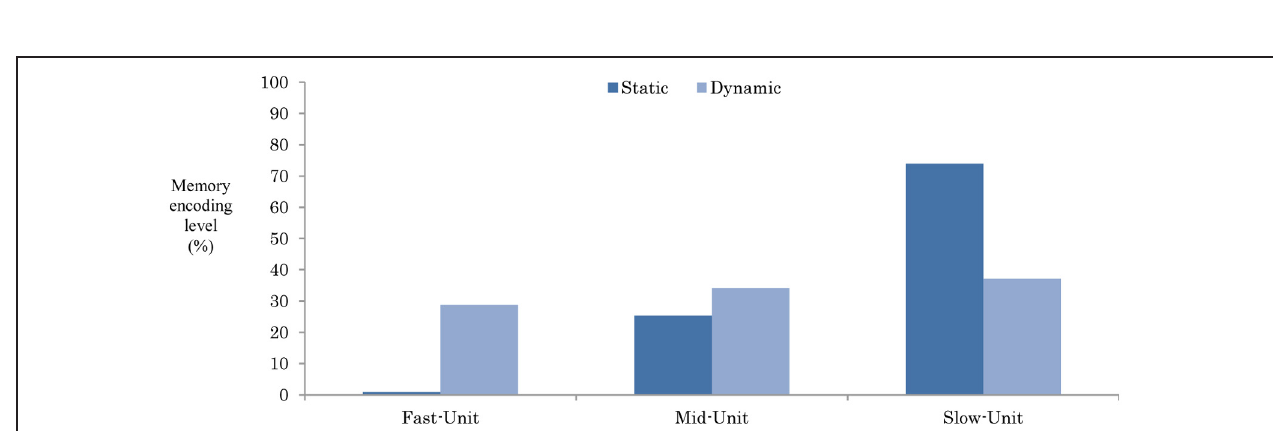
black plots illustrate the original task before the task interruption; and green plots illustrate the original task after the task interruption. From the phase plots, particularly in the slow and mid-context units, slight differences between the representation of black and green plots are observed.